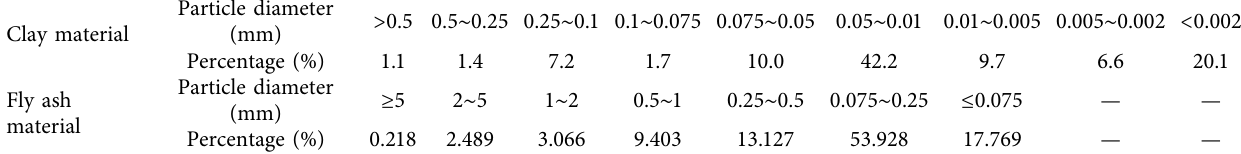
Table 2: Gradation distribution of grouting Material particles.